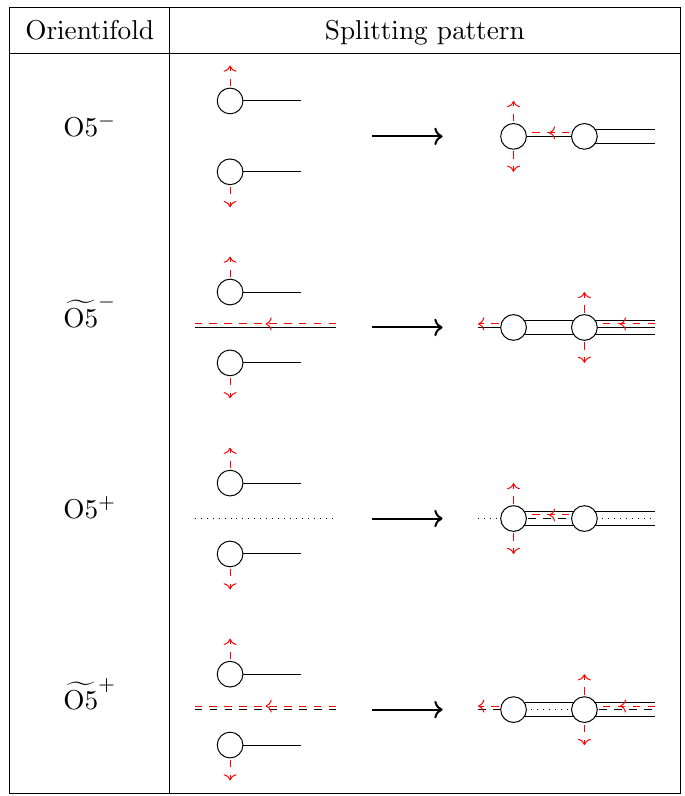
Table 13 . Splitting of D7 branes, with D5 branes ending on them, on various O5 planes. Ortho-symplectic linear